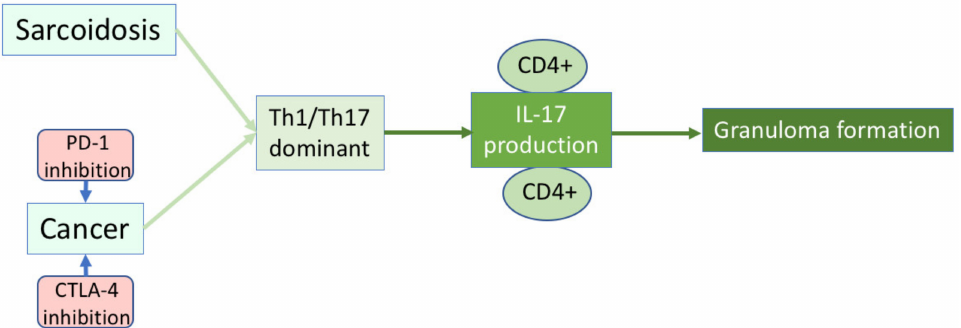
Figure 1. Mechanisms of development of sarcoidosis and ICI-induced sarcoid-like granuloma